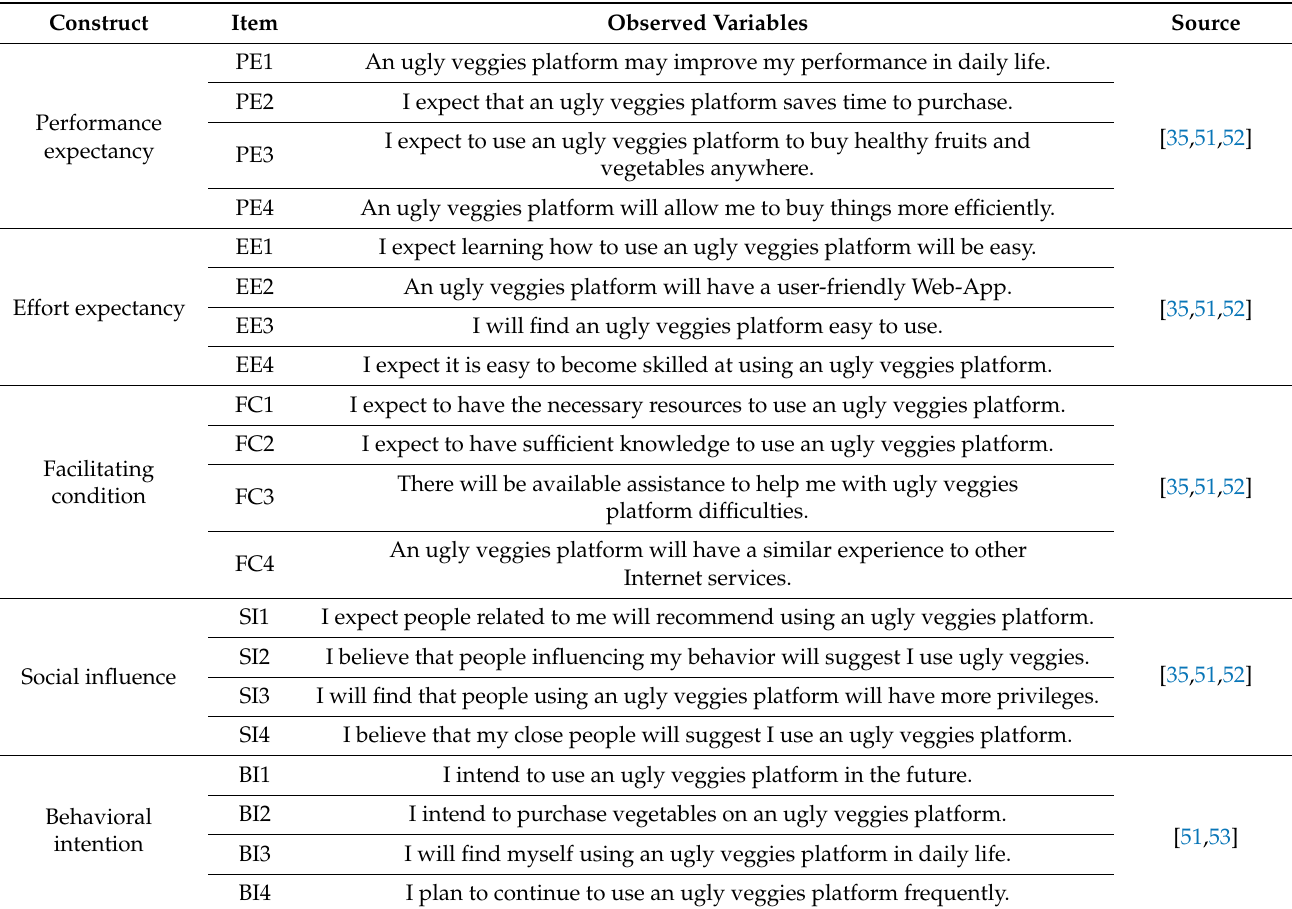
Table 1. Details of constructs and factors.